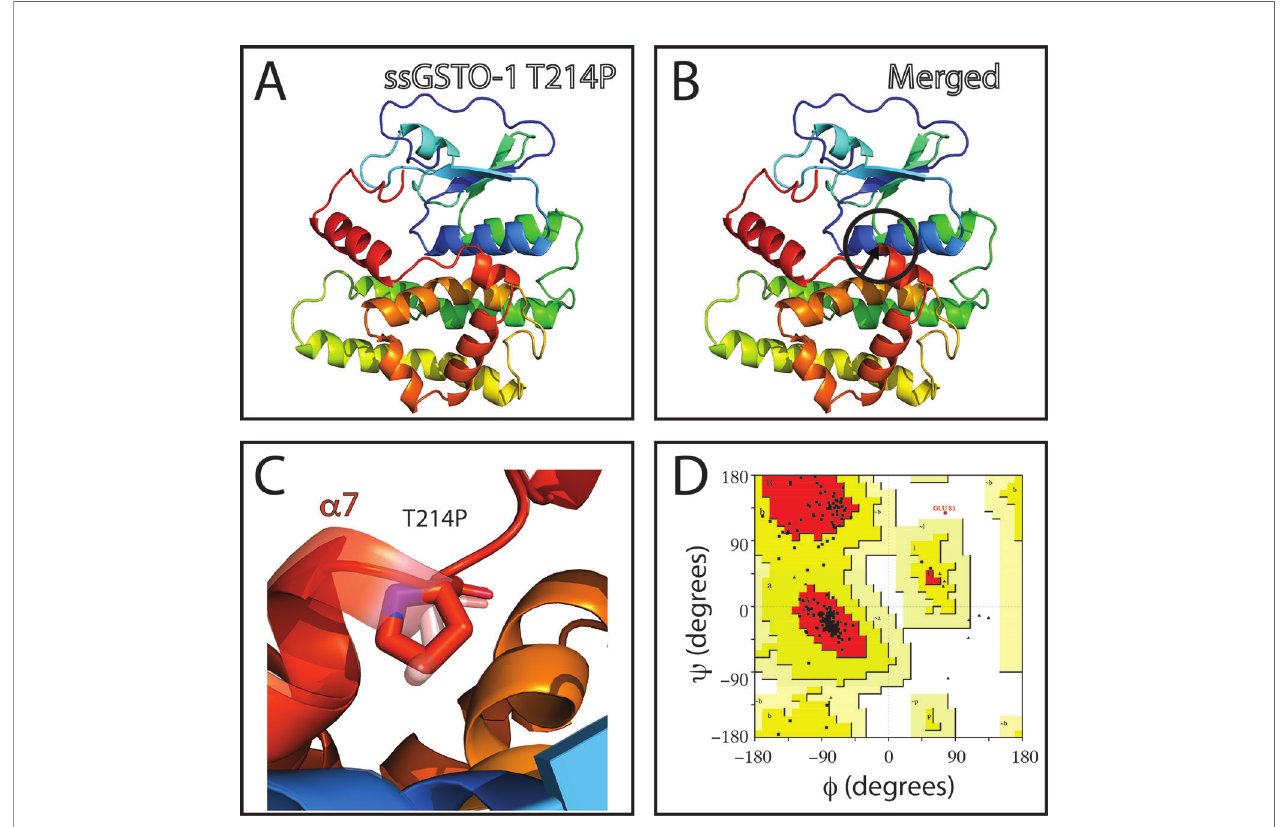
FIGURE 5 | Evaluation of single-nucleotide polymorphism (SNP) c.769A > C effect on the predicted S. salar GSTO-1 (sGSTO-1) structure by homology modeling. (A) Predicted tridimensional sGSTO-1 including the T214P substitution (sGSTO-1 T214P). (B) sGSTO-1 and sGSTO-1 T214P overlay. The punctual amino acid substitution (dotted arrow line) and the region of the secondary structure affected ( a 7 helix, circle) are indicated. (C) Enlarged view of the sGSTO-1 T214P substitution shown in (B) . (D) Ramachandran plot for the predicted sGSTO-1 structure. The amino acid distribution into most favored regions (A,B,L), additional allowed regions (a,b,l,p), generously allowed regions (~a,~b,~l,~p), and disallowed regions (GLU83) is indicated. In the protein structures, a -helices ( a 1- a 8), b - sheets ( b 1-4) are indicated. The reduced glutathione (GSH) molecule is